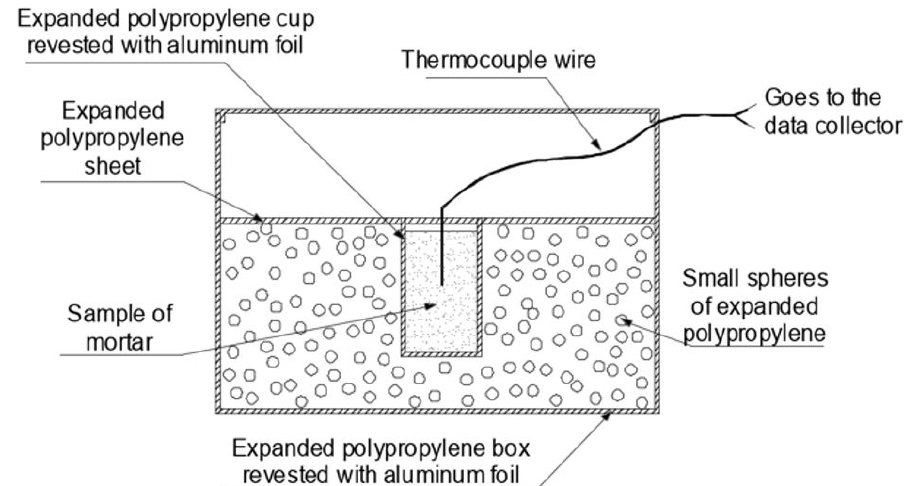
Figure 2. Scheme of the semi-adiabatic calorimeter in section.